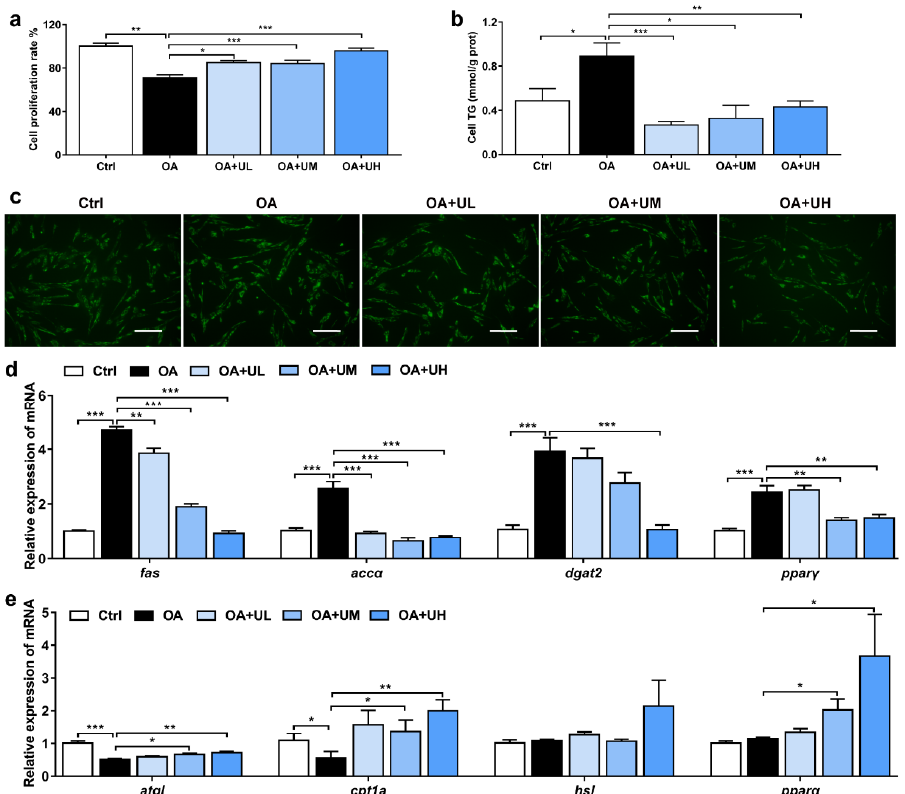
Figure 4. Uridine reduced the OA-induced accumulation of lipid droplets in the primary hepato- cytes of Nile tilapia. ( a ) The proliferation of cells that are analyzed by CCK-8 in oleic acid (OA)-induced cell model ( n = 10). ( b ) The contents of TG in the hepatocytes ( n = 6). ( c ) Lipid droplets staining with BODIPY 493/503 in the hepatocytes. Scale bar, 100 μ m ( n = 6). ( d , e ) Gene expression of lipid synthesis ( d ) and catabolism ( e ) in the hepatocytes ( n = 6). Statistics were analyzed by one-way ANOVA with Tukey’s adjustment and presented as mean ± SEM (*, p < 0.05; **, p < 0.01; ***, p < 0.001).